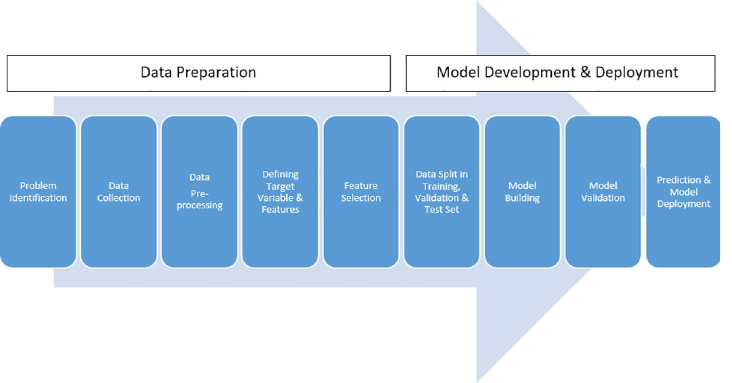
Fig 1. A typical machine learning process. Authors’ own